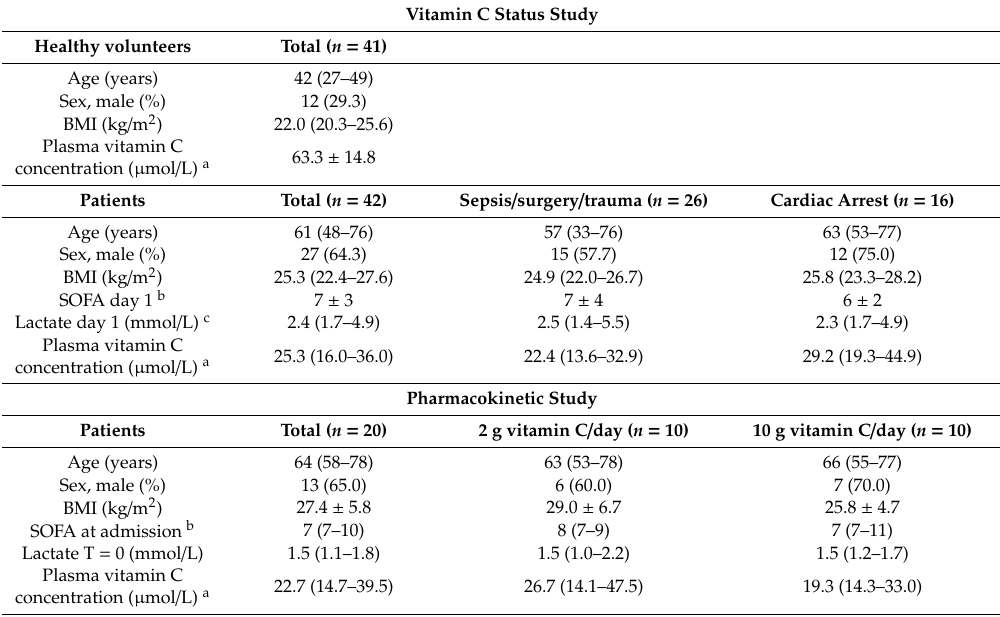
Table 2. Baseline